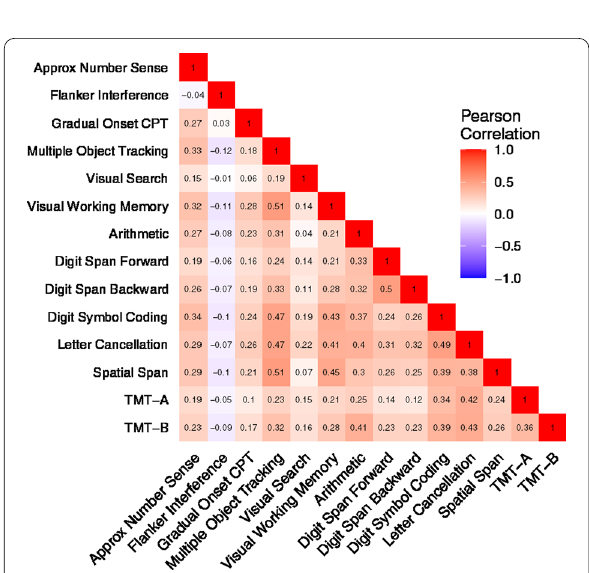
0.3. Flanker Inference had low loading on all five fac- tors, which was not surprising given the low correlations observed in the correlation matrix. Although Digit Sym- bol Coding had a loading over 0.3 on the first (Capacity)